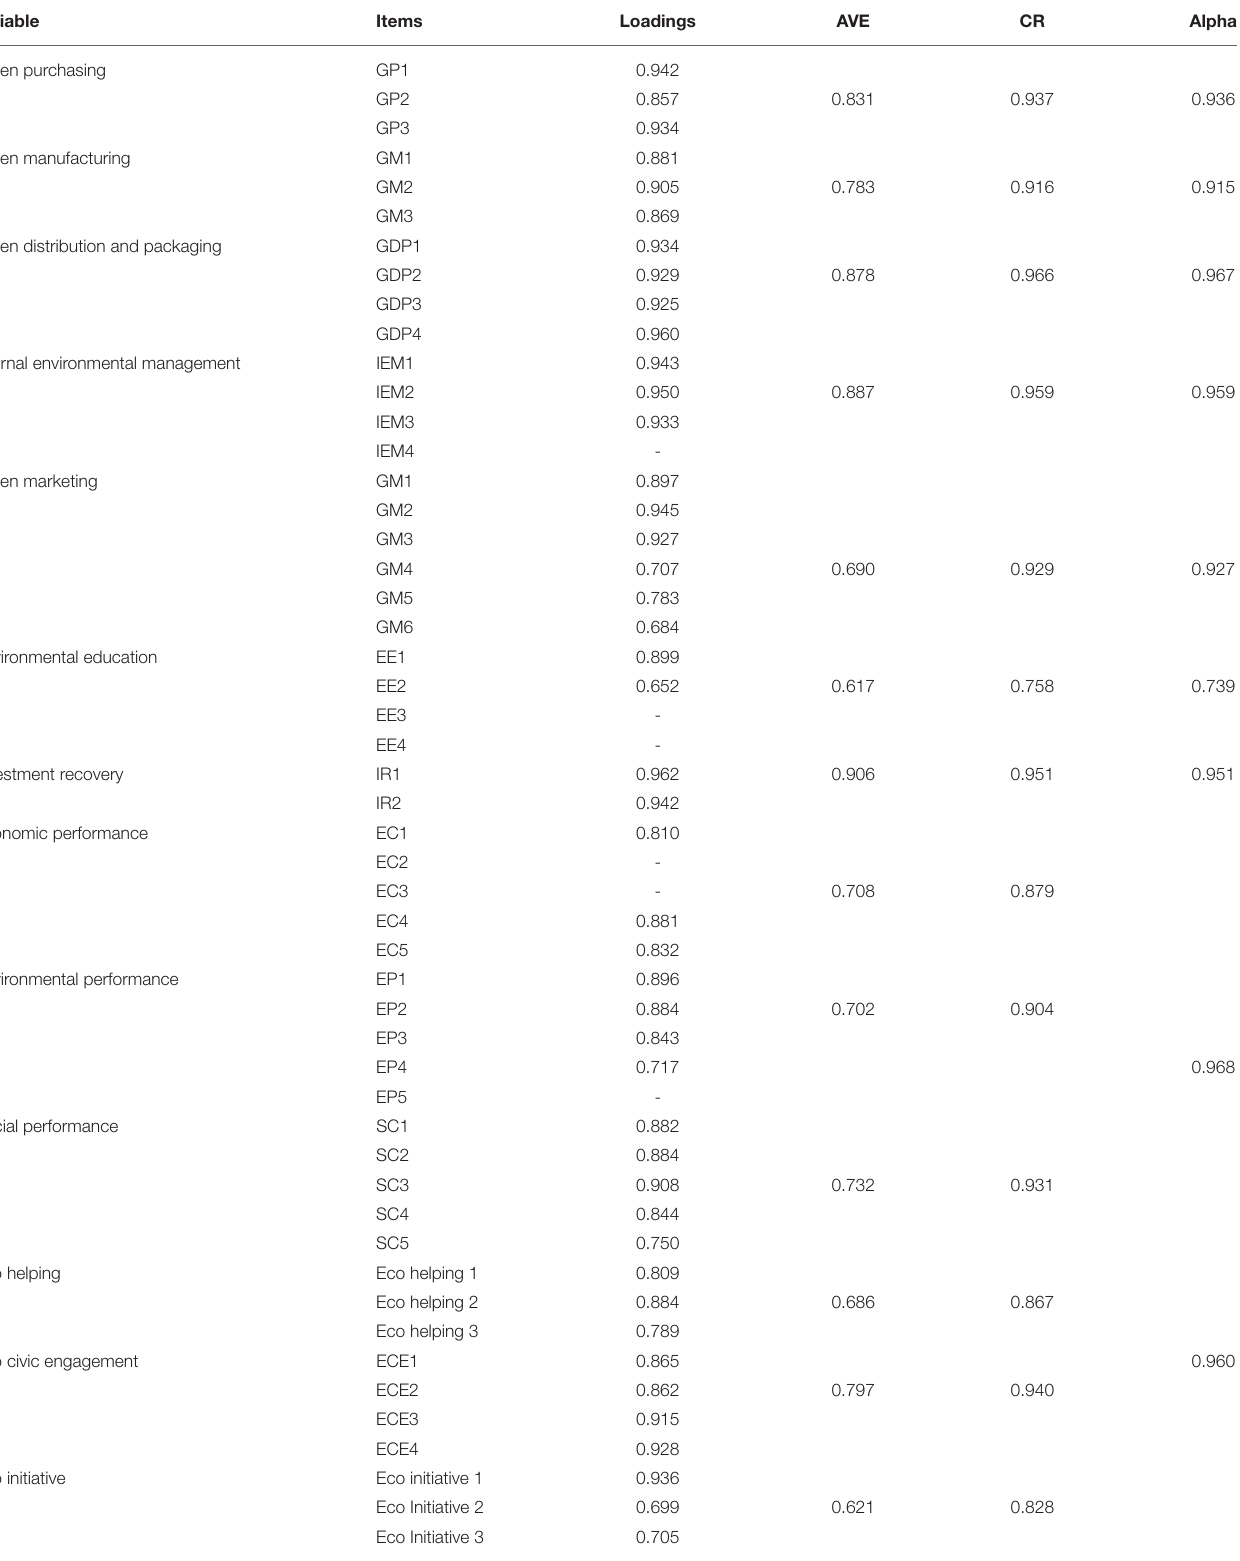
TABLE 1 | Measurement